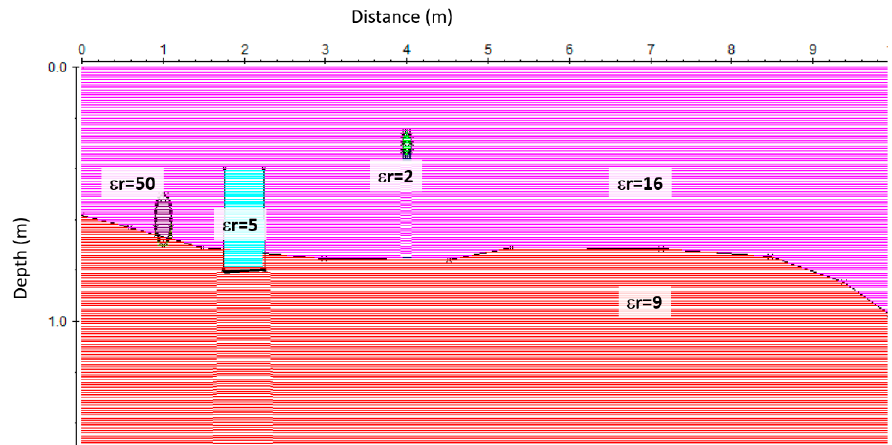
Figure 5. Forward model: two homogeneous layers with dielectric constants of 16 and 9 were modelled for the terrain and more compact layer, respectively. In the terrain, two pipes with different dielectric constant were inserted with ε r = 50 and ε r = 2. A wall feature, with a dielectric constant of 5, was placed at the contact between the two modelled layers.